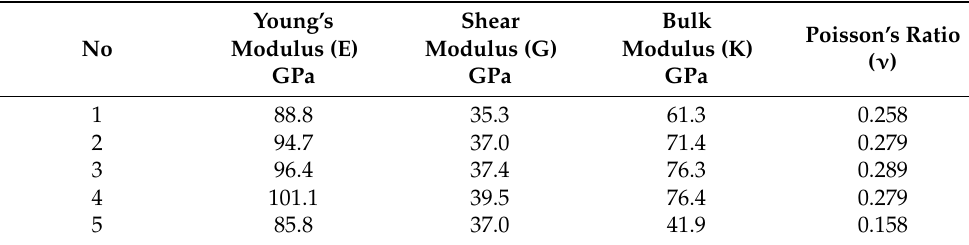
Table 2. The measured values of Young’s modulus, shear modulus, bulk modulus and Poisson’s ratios. Young’s No Modulus (E)